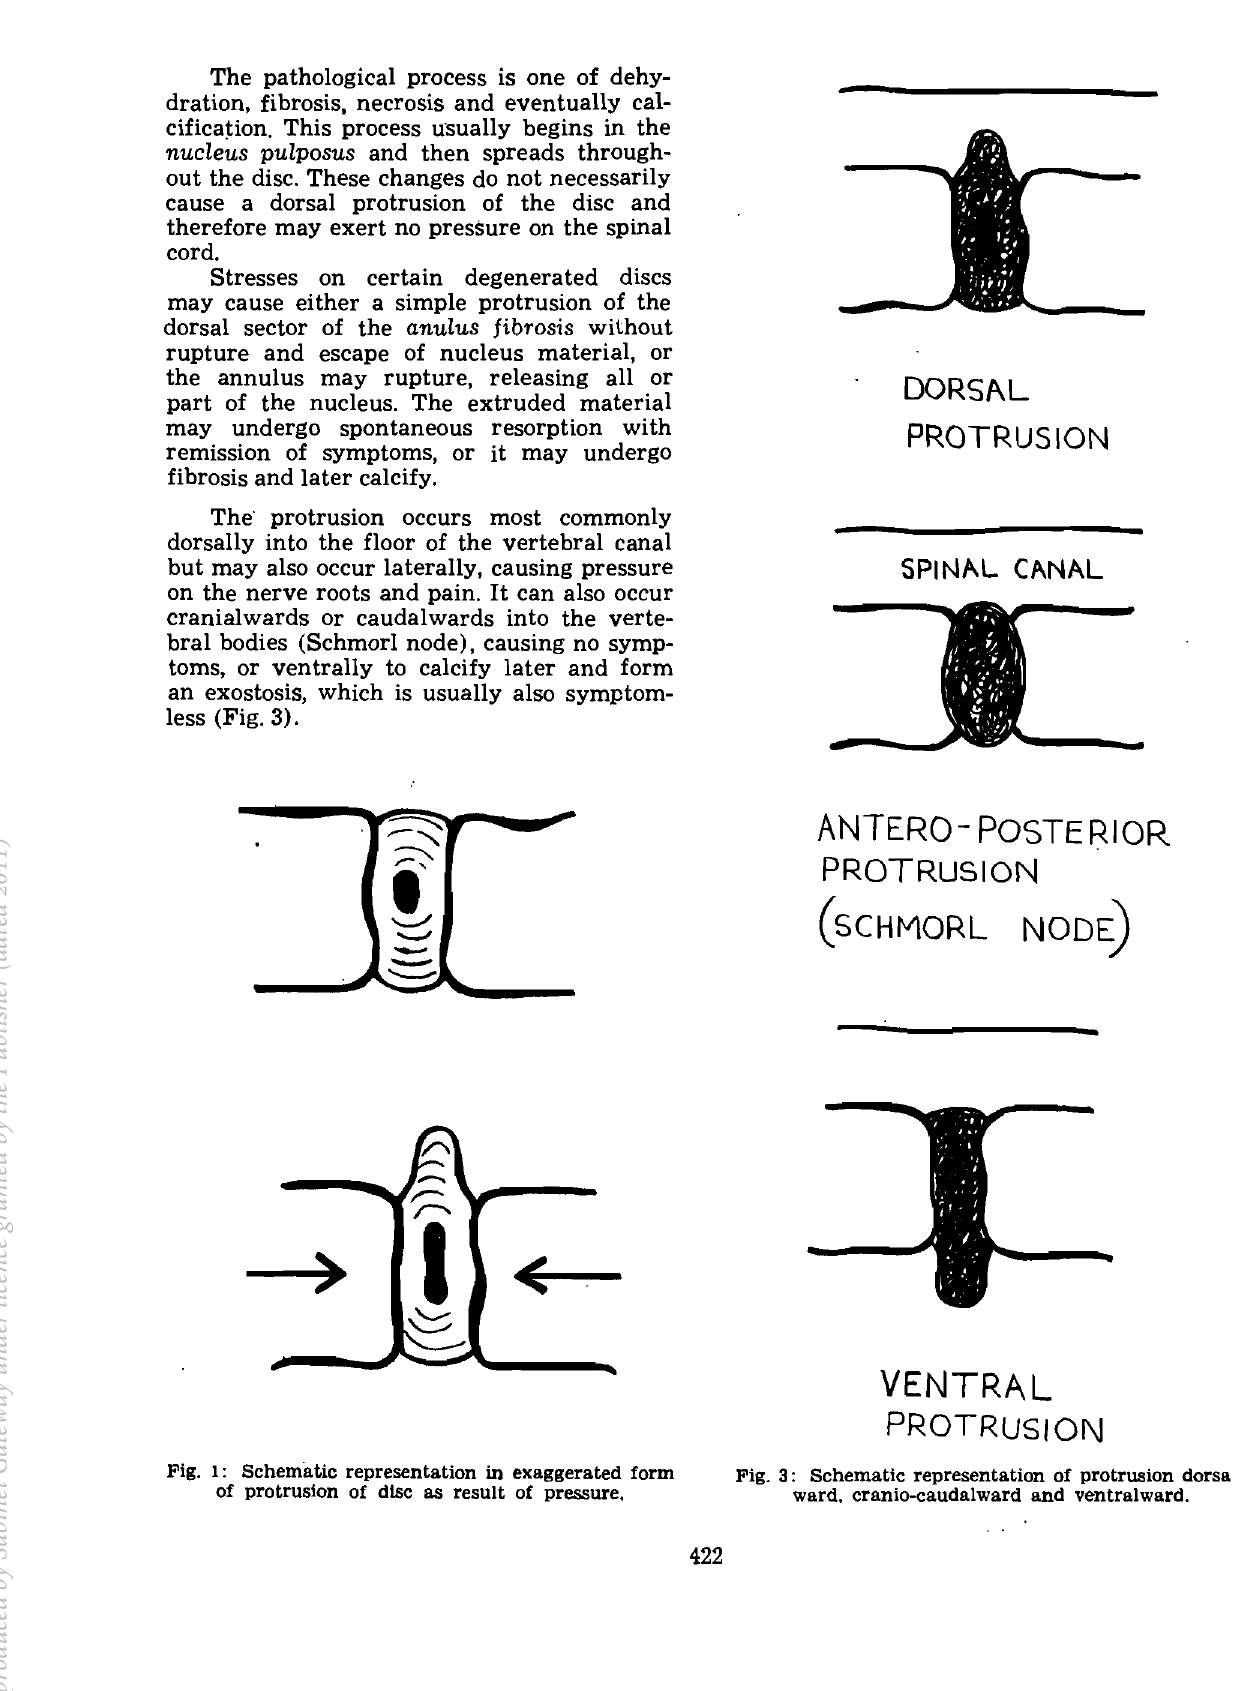
Fig. 3: Schematic representation of protrusion dorsa ward. cranio-caudalward and 422